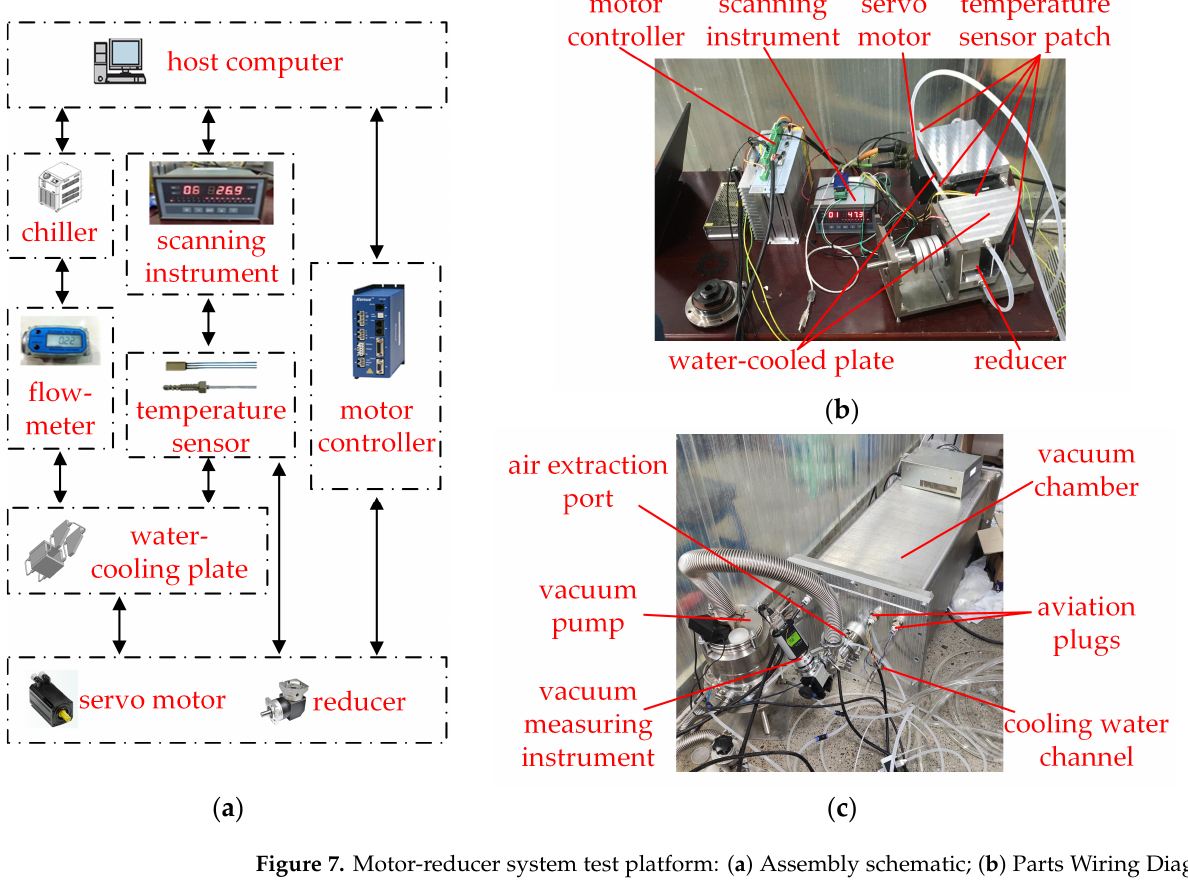
Figure 7. Motor-reducer system test platform: ( a ) Assembly schematic; ( b ) Parts Wiring Diagram; ( c ) Vacuum Chamber Wiring Diagram. Table 5. Equipment parameter